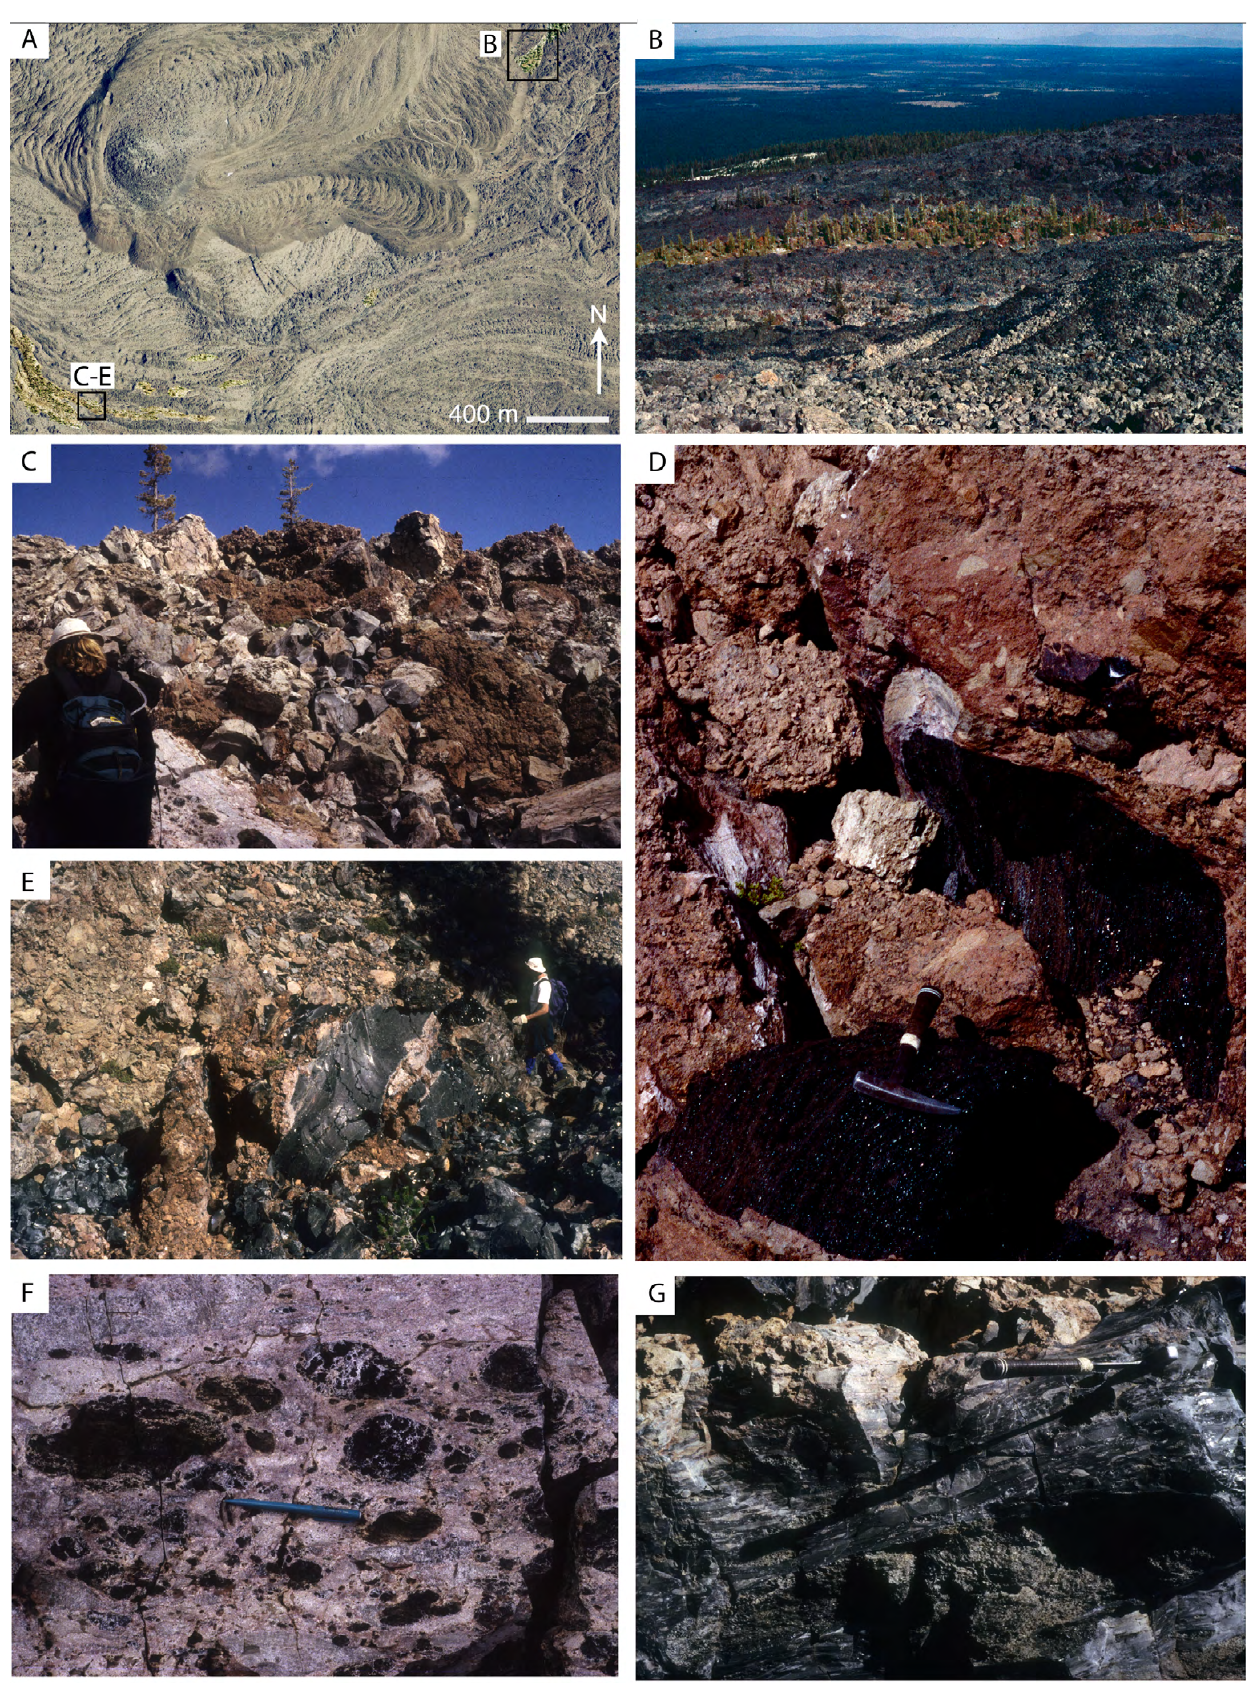
Figure 2: [Caption on next